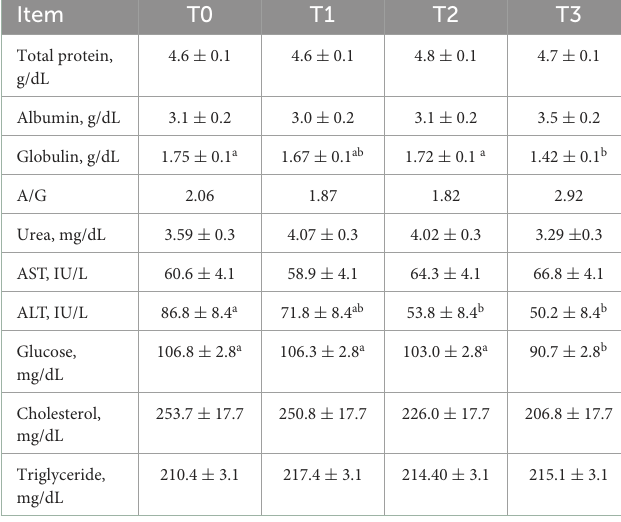
TABLE 4 The least-square means ± standard error of blood plasma parameters in the different studied